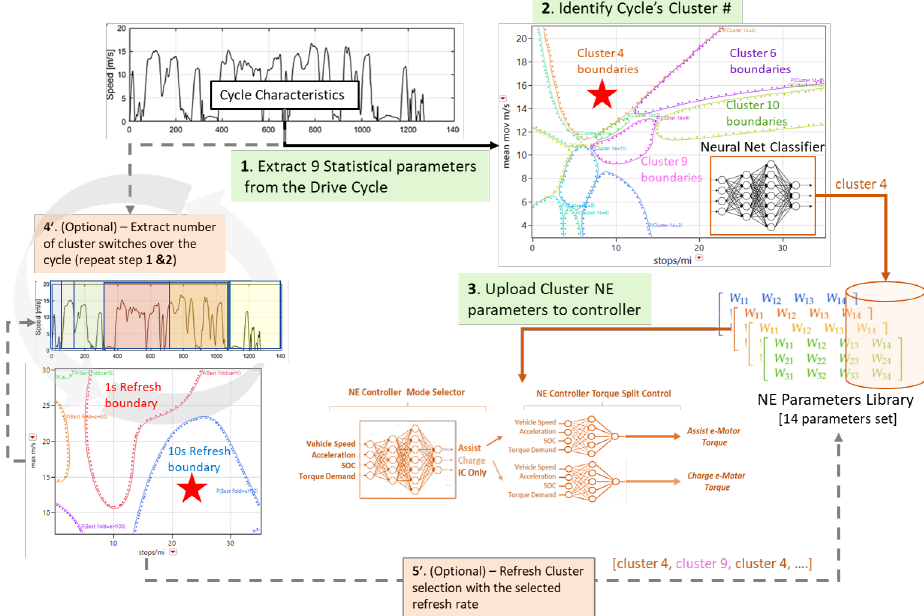
Figure 16. The proposed Neuroevolution based control architecture with the added classification refresh concept. Note that the classifier plot is only a static 2D view of the classification